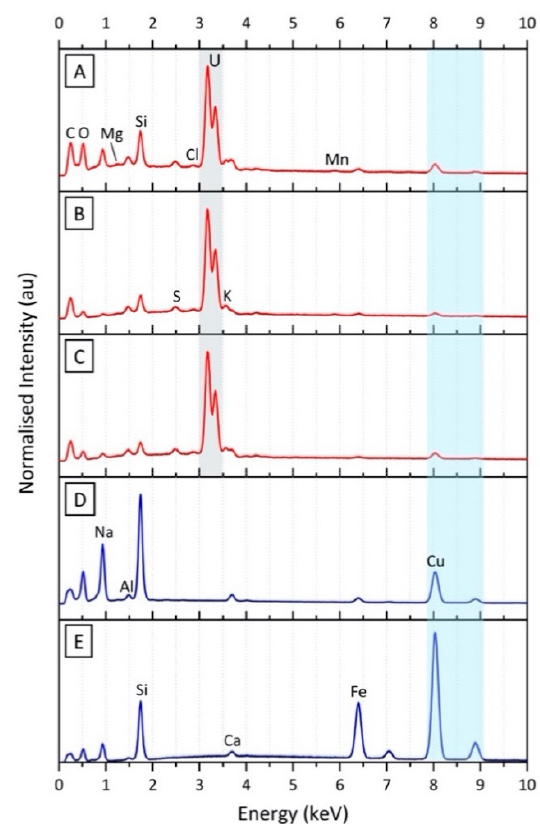
Figure 6. ( a ) and ( b ) Mixed Backscattered electron (BSE) and Secondary electron (SE2) images showing a typical U composition (high Z number) mineral grain (white) against the surrounding (low Z number) matrix (dark), EDS compositional maps of the mineral grain identified in ( a ), detailing the distribution of ( c ) U, ( d ) Si, ( e ) Cu, and ( f ) O. Scale bars = 5 µm. The locations at which EDS point analysis results (A–E) were also obtained and identified, as shown in Figure 7.